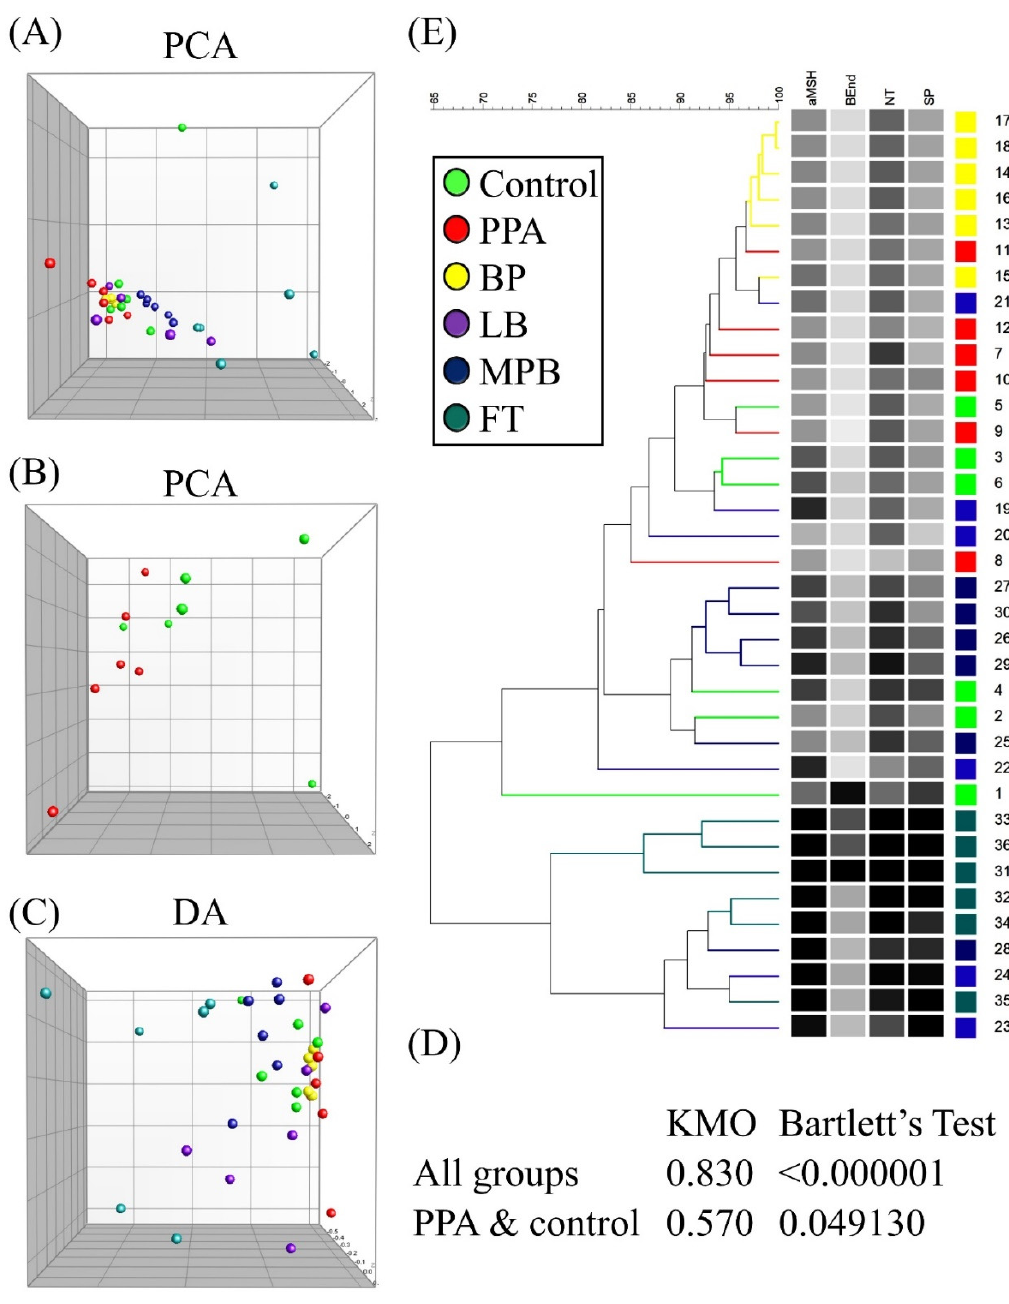
Figure 2. Clustering of treatment groups using principal component analysis (PCA) ( A , B ), discrimi- nant analysis (DA) ( C ), and hierarchical clustering ( E ). PC1 and PC2 in PCA and DA are represented by the x and y axes, respectively. Kaiser–Meyer–Olkin (KMO) and Bartlett’s test of sphericity results are shown for all groups and PPA and control groups ( D